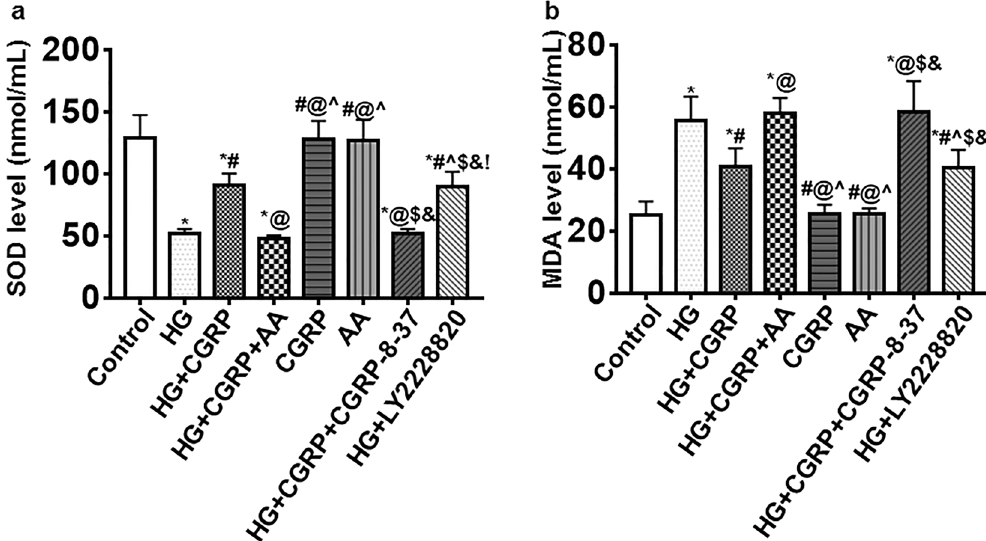
Figure 2. The oxidative stress level of BSMCs was measured by SOD and MDA kits. ( a ) Compared with the control, CGRP and AA groups, the SOD levels in the other groups decreased, but the SOD levels in the HG + CGRP and HG + LY2228820 groups were higher than that in the HG group, HG + CGRP + AA and HG + CGRP + CGRP-8-37 groups. ( b ) Compared with the control, CGRP and AA groups, the MDA level in the other groups increased but the MDA levels in the HG + CGRP and HG + LY2228820group were lower than that in the HG group, HG + CGRP + AA and HG + CGRP + CGRP-8-37 groups. * VS. control group, p < 0.05; # VS. HG group, p < 0.05; @ VS. HG + CGRP group, p < 0.05; ^ VS. HG + CGRP + AA group, p < 0.05; $ VS. CGRP group, p < 0.05; & VS. AA group, p < 0.05; ! VS. HG + CGRP + CGRP-8-37 group, p < 0.05. n = 6. The bar charts were created by GraghPad Prism 7.0 software (Version 7.00, URL: www. graph pad.